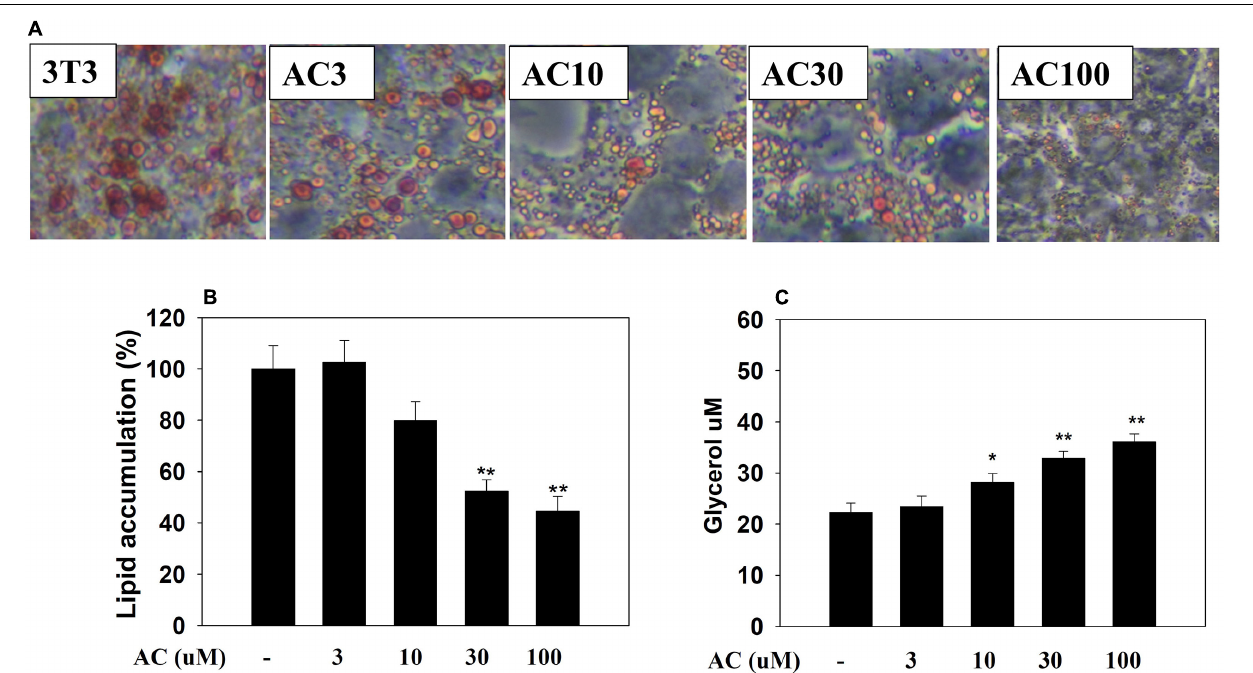
FIGURE 1 | Acacetin (AC) (3–100 µ M) reduces adipogenesis in 3T3-L1 cells. (A) Oil red O stain was used to evaluate lipid accumulation in cells treated with the indicated concentration of acacetin. (B) 3T3-L1 cells were treated with isopropanol and lipid accumulation was measured using the absorbance at OD 490 nm. Lipid accumulation in control group cells compared to acacetin-treated 3T3-L1 cells. (C) Glycerol concentrations were determined in the culture medium. Data are presented as means ± SD, n = 6. ∗ P < 0.05, ∗∗ P < 0.01 compared with the control group.